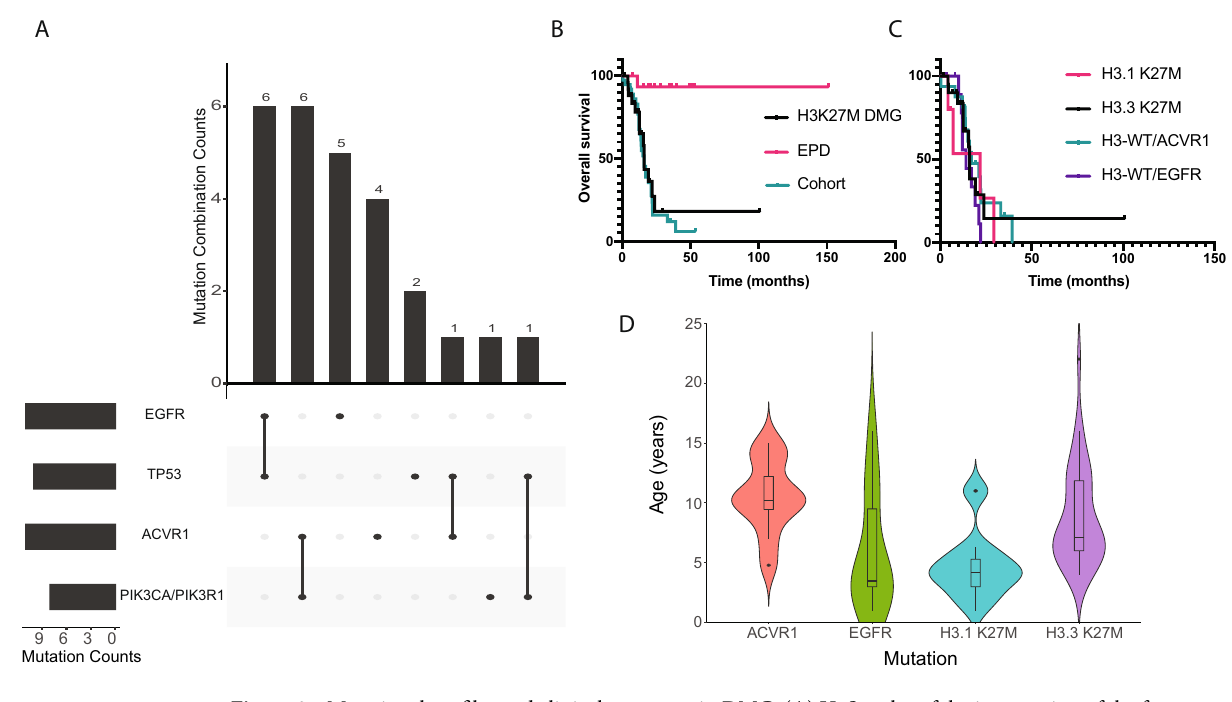
Figure 3. Mutational profiles and clinical outcomes in DMG. ( A ) UpSet plot of the intersection of the four predominant mutations ( EGFR, TP53, ACVR1, PIK3CA/PIK3R1 ) observed in H3-WT midline gliomas. ( B ) Kaplan–Meier overall survival analysis comparing H3K27M DMG (N = 27), EPD (N = 16) and the glioma tumour cohort (N = 38). ( C ) Kaplan–Meier overall survival analysis comparing the mutations of interest in this study, respectively H3.3 K27M (N = 21), H3.1 K27M (N = 6), H3-WT ACVR1 (N = 16) and H3-WT EGFR (N = 11). ( D ) Violin plot showing the age distribution of H3-WT ACVR1 (N = 11), H3-WT EGFR (N = 10), H3.1 K27M (N = 18), and H3.3 K27M (N = 36). Horizontal line is the median age and the ends of the box represent the upper and lower quartiles. A black dot indicates the age being greater than two standard deviations from the mean age of the